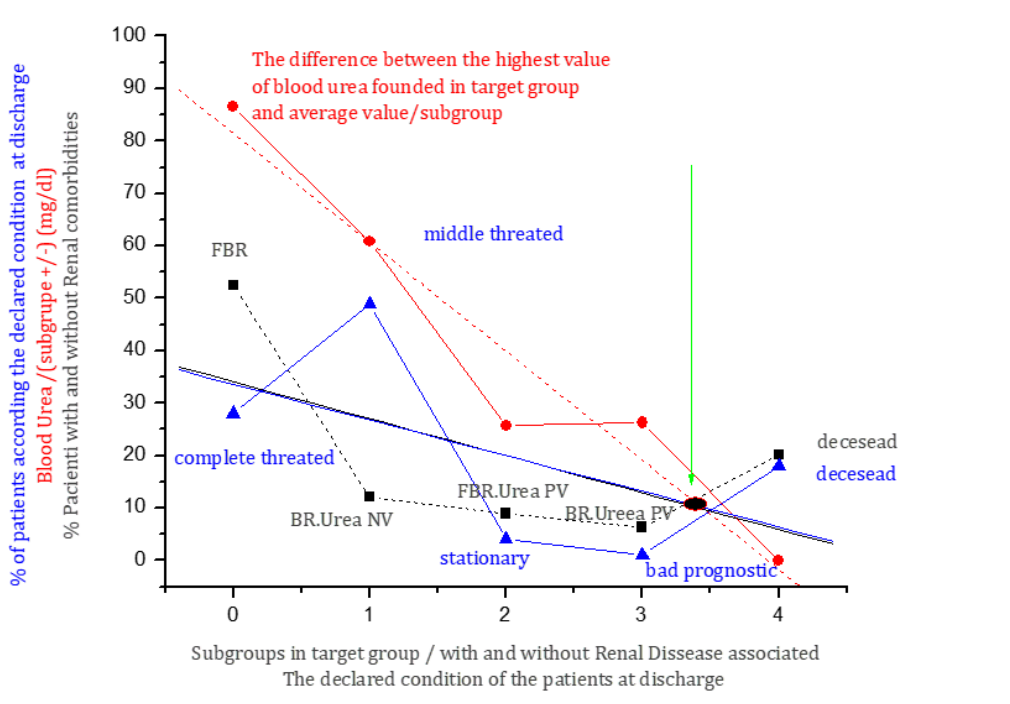
Figure 7. The increase in the risk of death in patients from the target group above the uremia value of 92 mg/dl Legend: FBR=patients without kidney disease, BR urea VN=patients with kidney disease with normal uremia values, FBR urea VP=patients without kidney disease but with pathological values of uremia, BR urea VP=patients with kidney disease with pathological values of